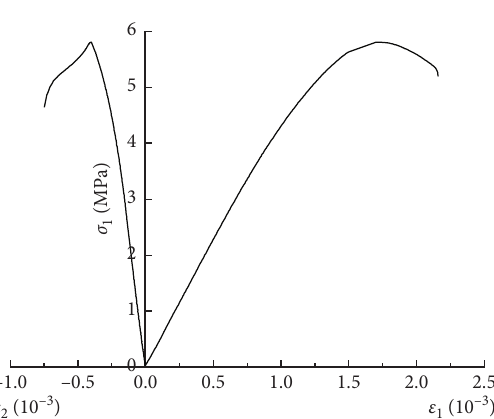
Figure 5: Typical stress-strain curves of the test sample under uniaxial compression.